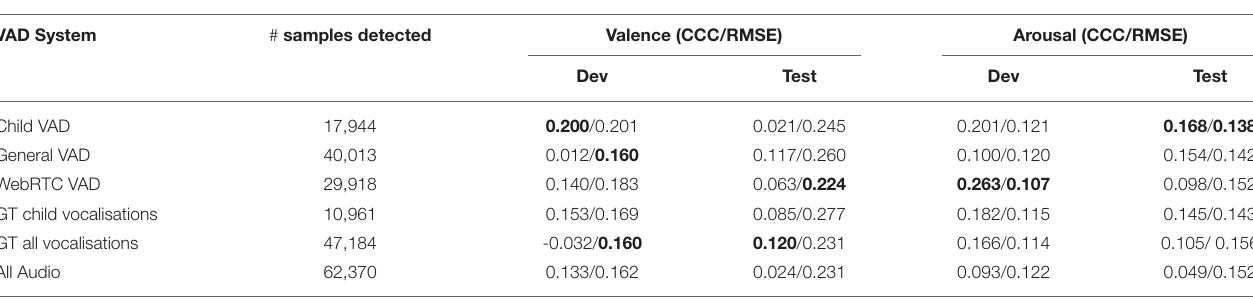
TABLE 3 | Results of the speech emotion recognition (SER)